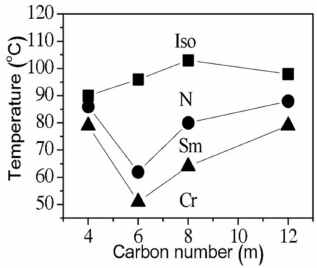
Figure 5. A plot showing the transition temperature as a function of spacer length on cooling.